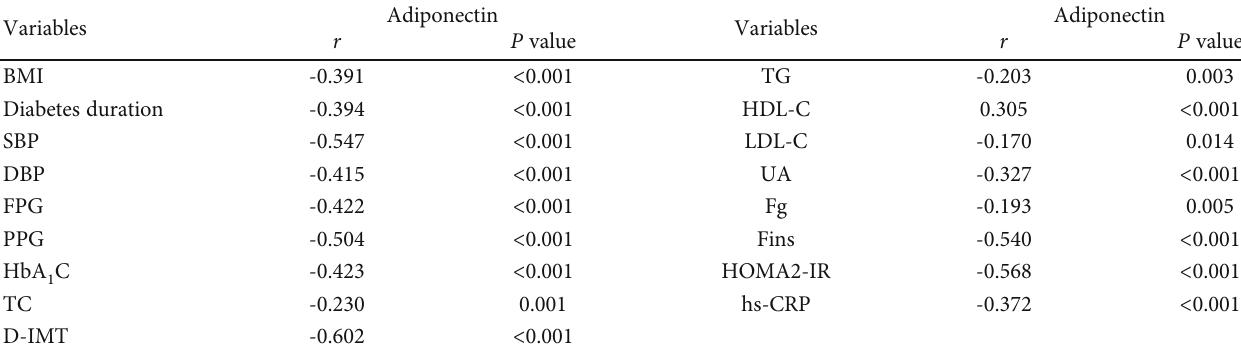
Table 4: Partial correlation analysis between adiponectin and relevant clinical indexes.